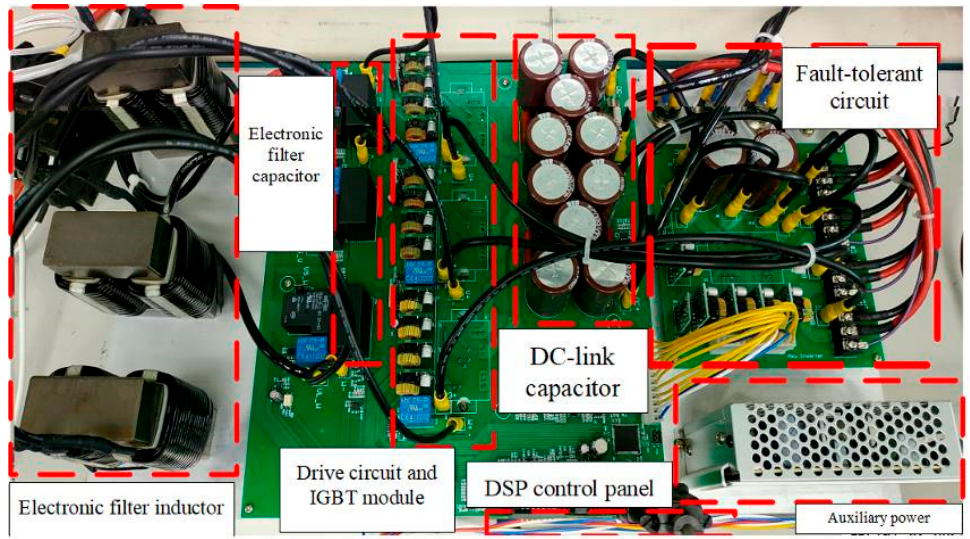
Figure 19. Experimental hardware circuits for the three-level NPC inverter.